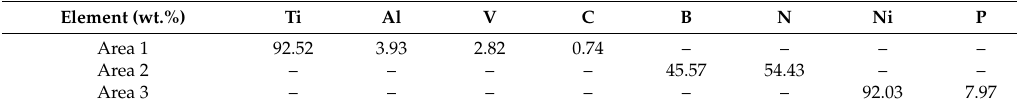
Table 1. The elemental concentration of the selected areas in Figure 1.